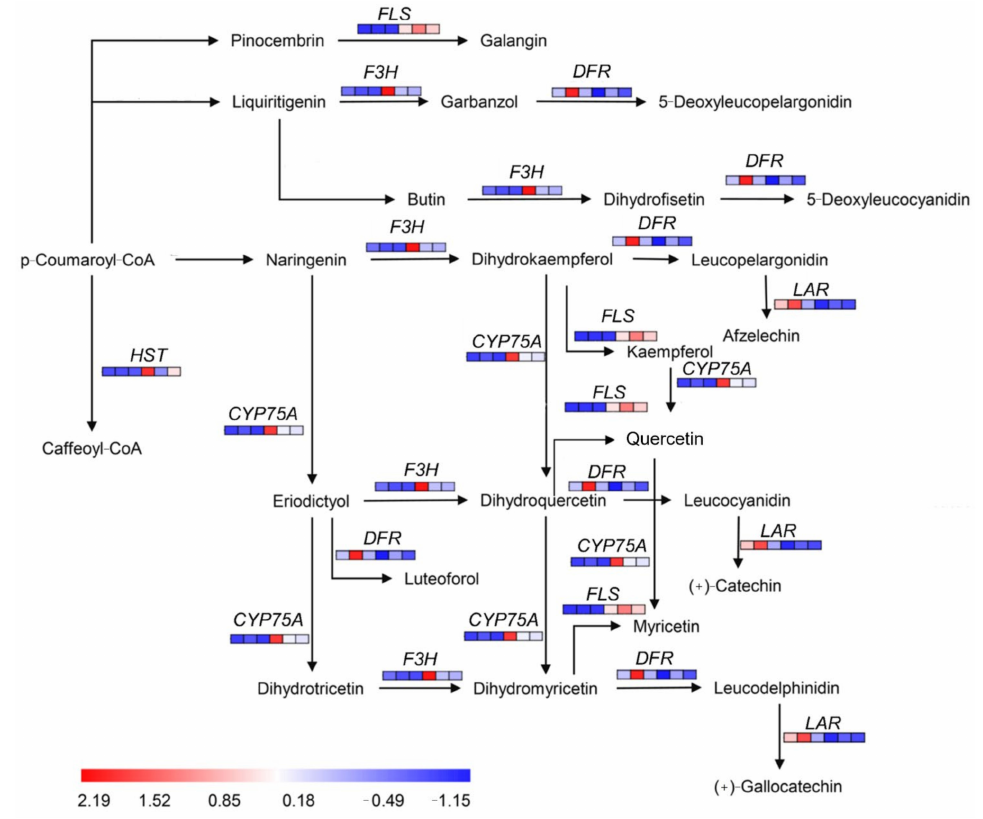
Figure 7. Schematic diagram of DEGs in the flavonoid biosynthesis pathway of haploid